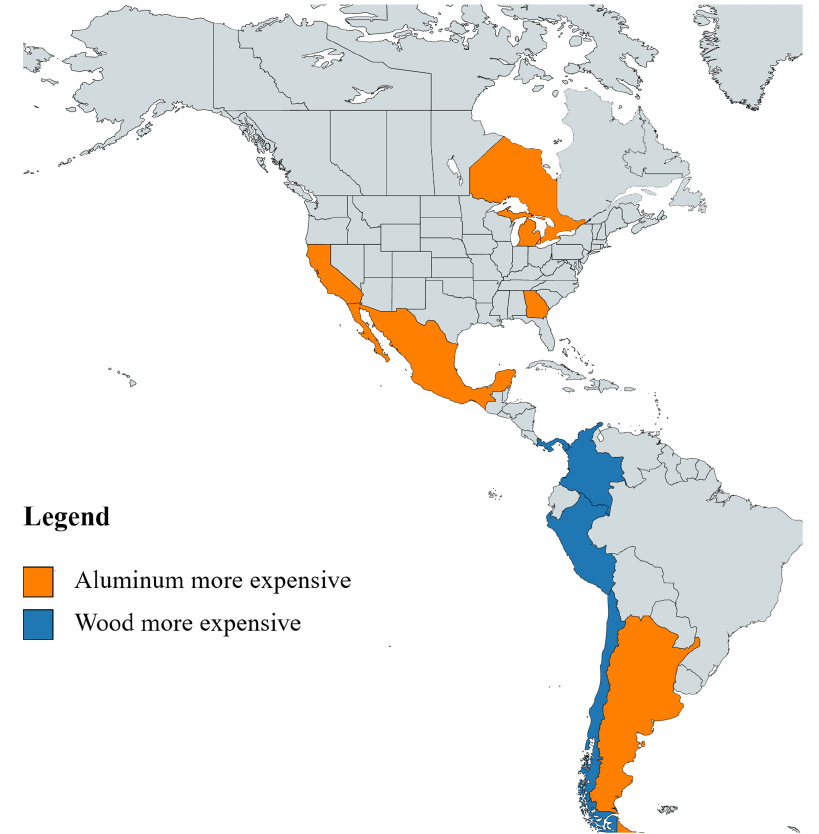
Figure 4. Results of economic analysis for wood and aluminum PV racking.